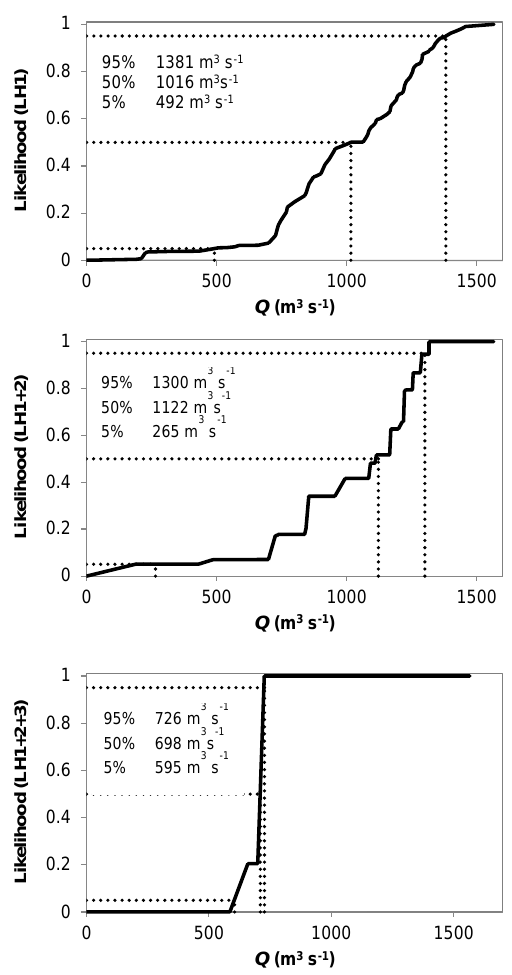
Figure 4. DT_control cumulative density function (CDF) data for T = 150min (solid line). Changes to likelihood values resulting from Bayesian updating are ultimately translated to changes in the form of the CDF curve, from which percentile Q data are extracted at 5, 50, and 95% confidence intervals (dashes). LH1 = final breach depth; LH1 + 2 = final breach depth + centreline elevation pro- file; LH1 + 2 + 3 = final breach depth + centreline elevation pro- file + flow constriction